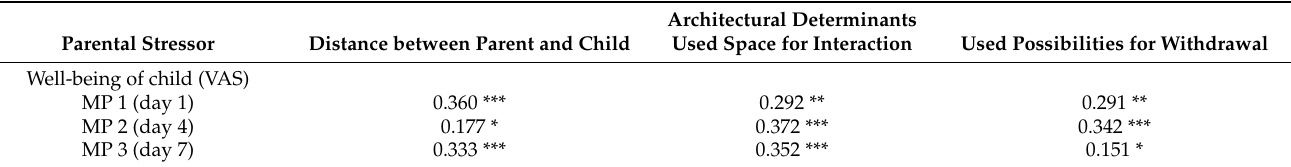
Table 4. Correlations of the estimated well-being of the child and architectural determinants of patient room across three measure